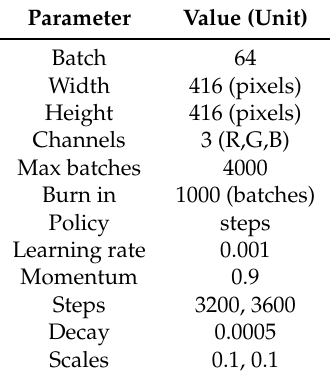
Table 3. Configuration for YOLO.